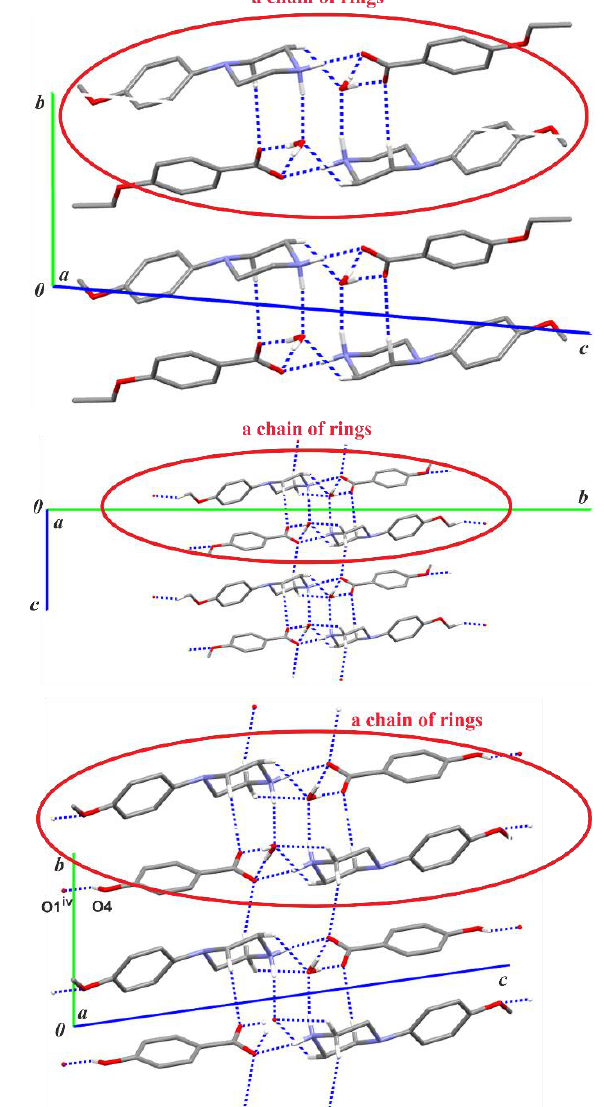
Figure 4. Part of the crystal structures ( a ) of compound (I), ( b ) (II) and ( c ) (III) showing the basic chain-of-rings motifs parallel to the [100] direction, including the C—H ··· O intermolecular interactions. For the sake of clarity, the H atoms bonded to C atoms not involved in the motif shown have been omitted. [Symmetry code: (iv) x , y , z − 1.].